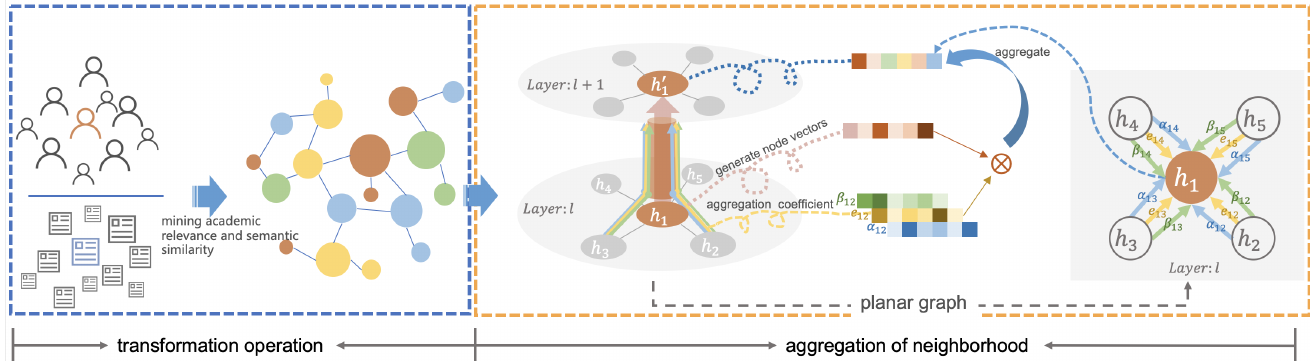
Figure 2. Diagram of the overall framework of the Association Content Graph Attention Network (ACGAT). The left part is the transformation operation, which transforms the discrete points into the resource graph structure. The right part is the aggregation operation, which aggregates the domain information and uses the final aggregation coefficient λ ij to get the new feature representation of the central